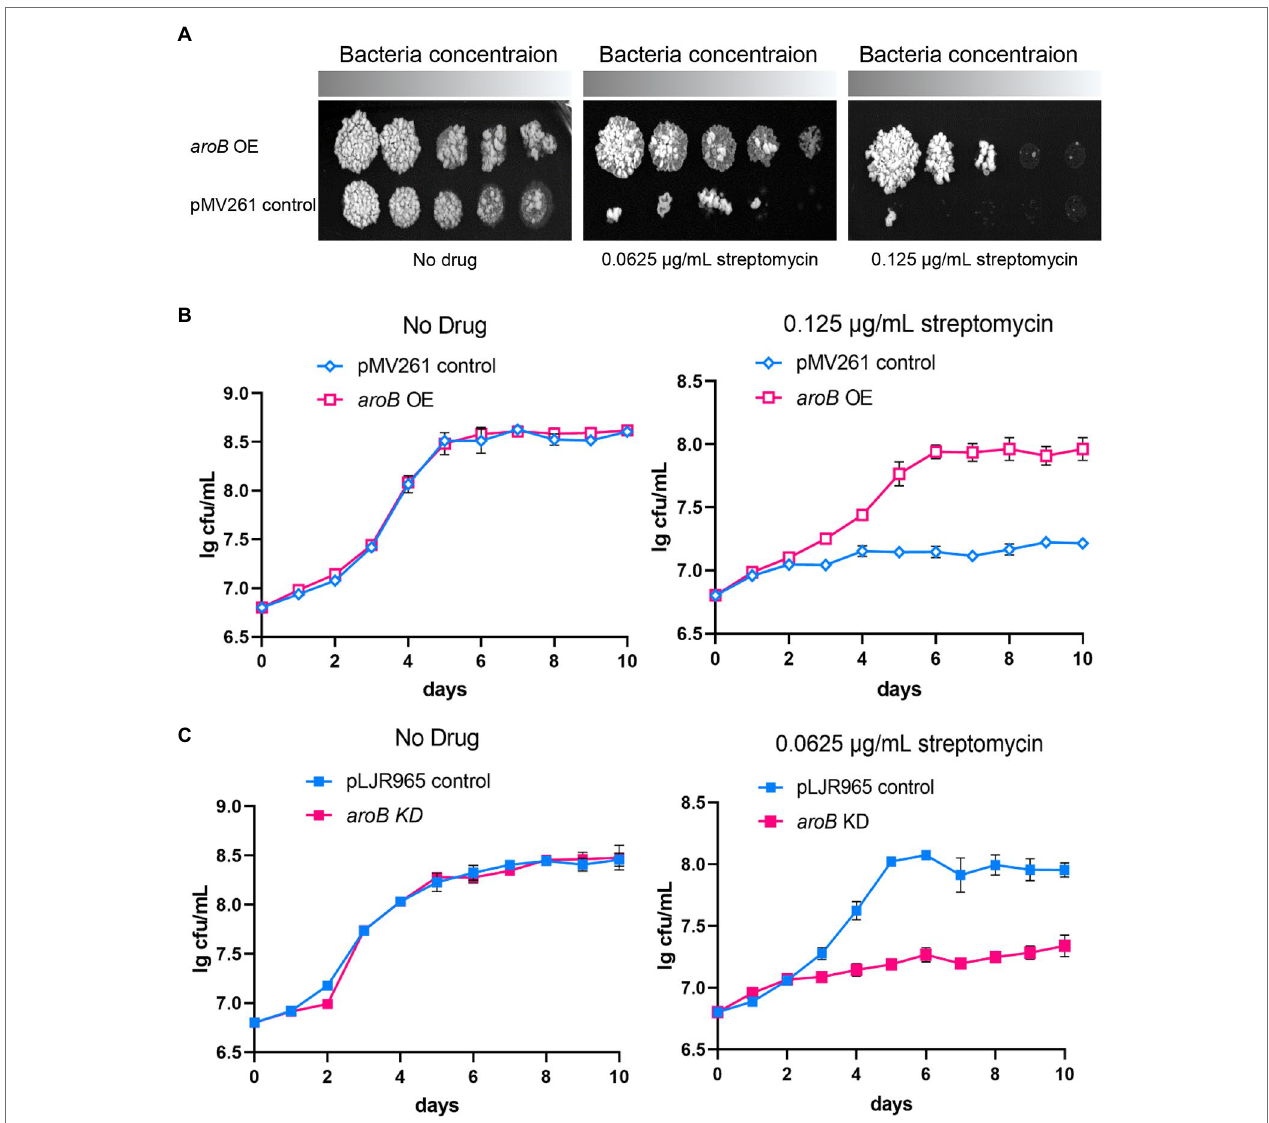
FIGURE 1 | Dehydroquinate synthase (DHQS) expression level affects streptomycin susceptibility of Mycobacterium bovis BCG. (A) Overexpression of aroB reduced the streptomycin susceptibility of M. bovis BCG. The growth of aroB overexpressing strain and control strain (empty plasmid) on solid medium added with 0, 0.0625, and 0.125 μ g/ml streptomycin was investigated. Freshly cultivated strains were grown on 7H9 medium until OD 600 reached 1.0. The serially diluted (10 − 0 , 10 − 1 , 10 − 2 , 10 − 3 , and 10 − 4 ) strains were spotted onto 7H10 plates containing OADC growth supplements and cultured for another 7 days at 37 ° C. (B) Growth of aroB overexpressing strain and control strain in liquid medium added with 0, 0.125 μ g/ml streptomycin. Growth curves of control strain and aroB -overexpressing strain in the medium with 0.125 μ g/ml streptomycin or without drug (No drug) during 10 days. Error bars represent the SD of three biological replicates. (C) Knock- down of aroB increased the streptomycin susceptibility of M. bovis BCG. Aliquots were sampled at the indicated times, and the CFU was measured. Error bars represent the SD of three biological